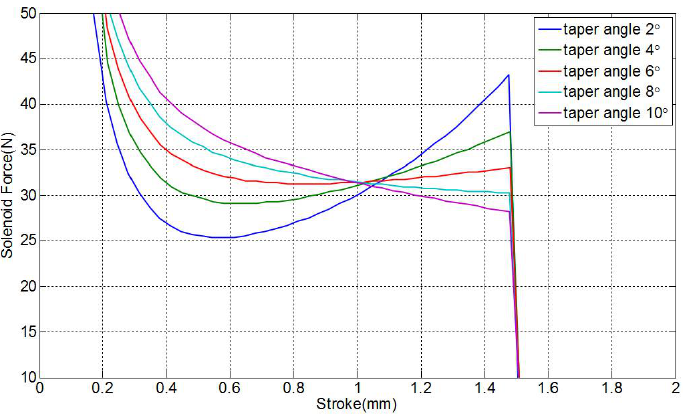
Figure 11. Simulation results for the taper angle.